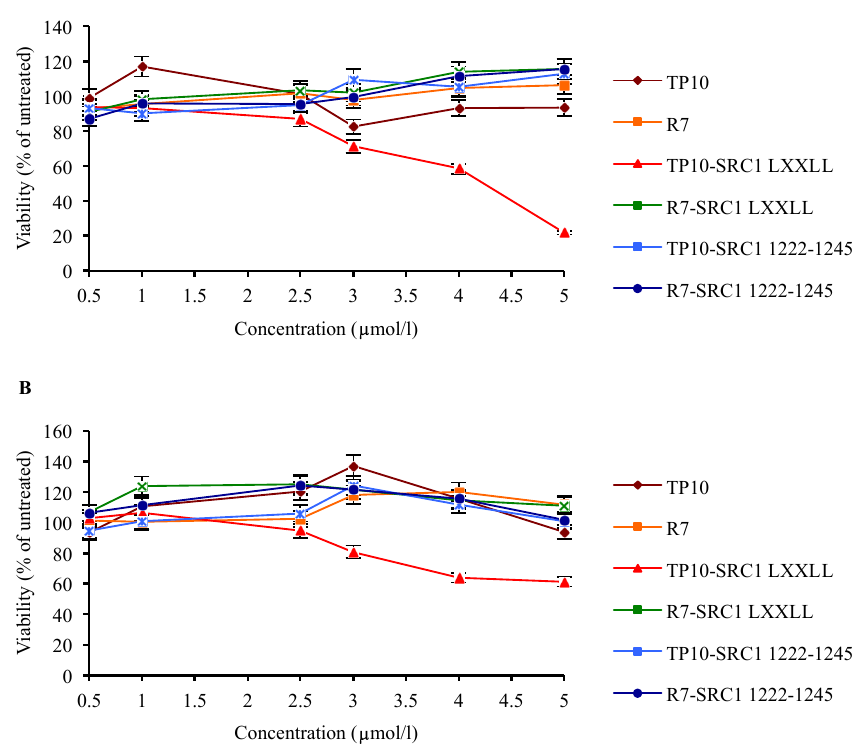
Figure 1. Effects of SRC-1 bioportides on cancer and primary fibroblast cells. ( A ) Viability of MCF-7 cells; ( B ) Viability of FB188 cells. Cells were seeded in 96-well plates at a density of 3000 or 2000 cells/well, respectively, and treated after every 24 h with the indicated peptide concentrations. Viability of both cell types was monitored at day 3 via the WST-1 assay. The values shown represent the mean values of one experiment, carried out in triplicate (mean ± SD). In total, three independent experiments were